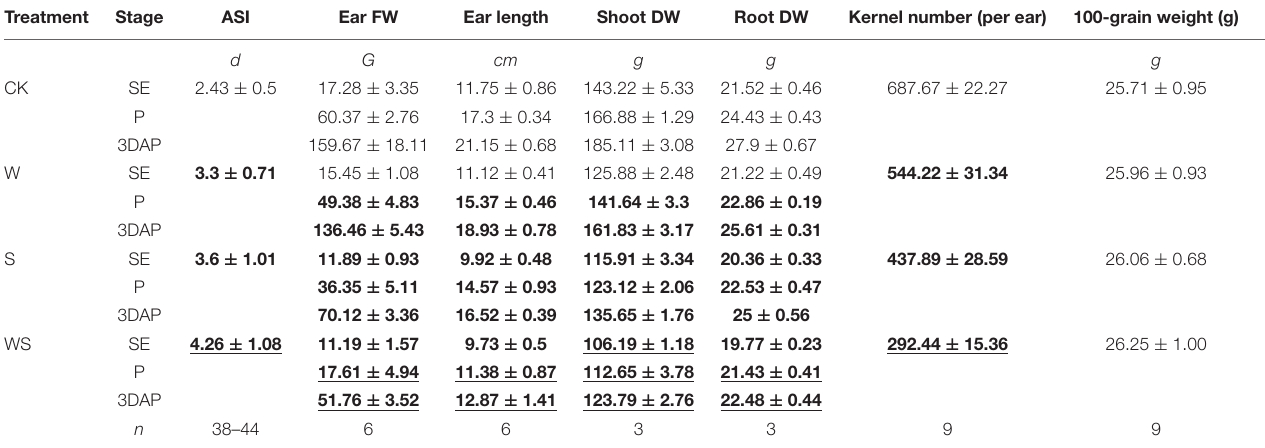
TABLE 1 | Phenotypes of maize plants in control (CK), waterlogging + shading (WS), waterlogging (W), and shading (S) treatment groups.